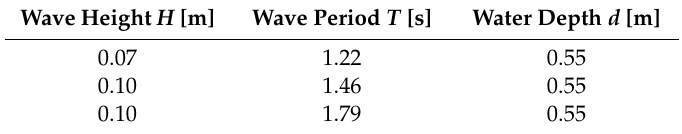
Table 2. Wave parameters for the numerical simulation in DualSPHysics and OpenFOAM. Wave Height H [m]